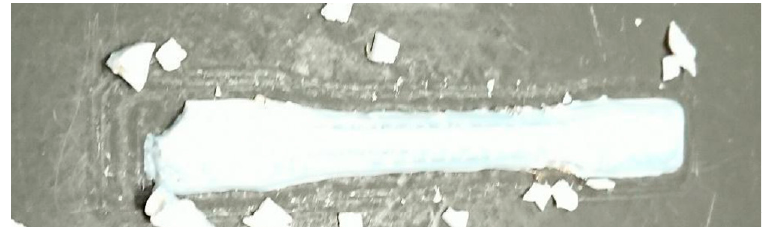
Figure 13. Tensile bar 3D printed in rPET from water bottle flake fractured on bed removal if 3D printed in humid open air.